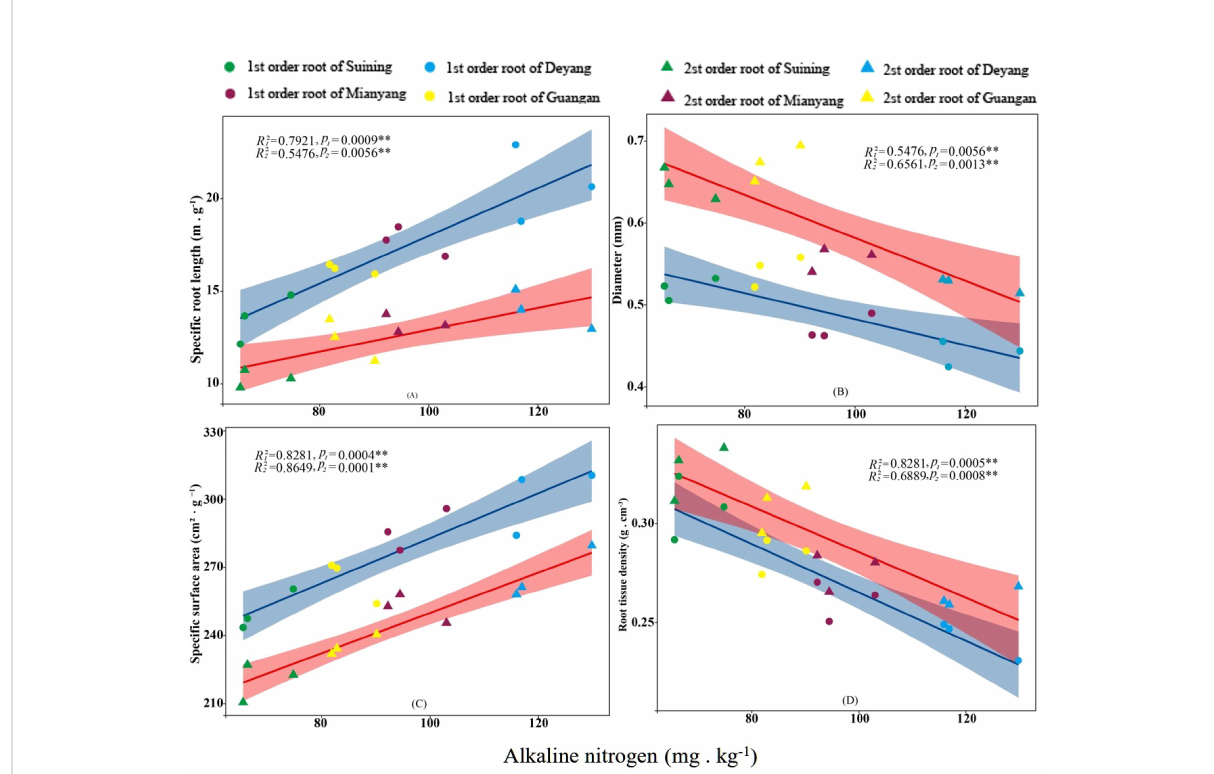
FIGURE 3 Effects of soil alkaline nitrogen on speci fi c root length, root diameter, speci fi c root surface area, and root tissue density at four research sites. R 12 and R 22 represent coef fi cients of determination for regressions of fi rst- and second-order fi ne roots *and **indicate signi fi cance at p < 0.05 and p < 0.01, respectively. p 1 and p 2 are p- values indicating signi fi cance of regressions with fi rst- and second-order fi ne roots, respectively. The shaded part is the con fi dence interval of the fi tting line, regimes (n = 3 per